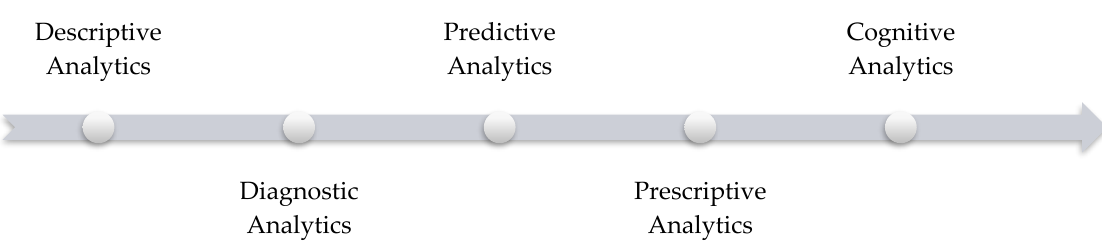
Figure 1. Advanced Analytics Maturity Path: Moving to Real-Time Enterprise. Source: own study based on [10].